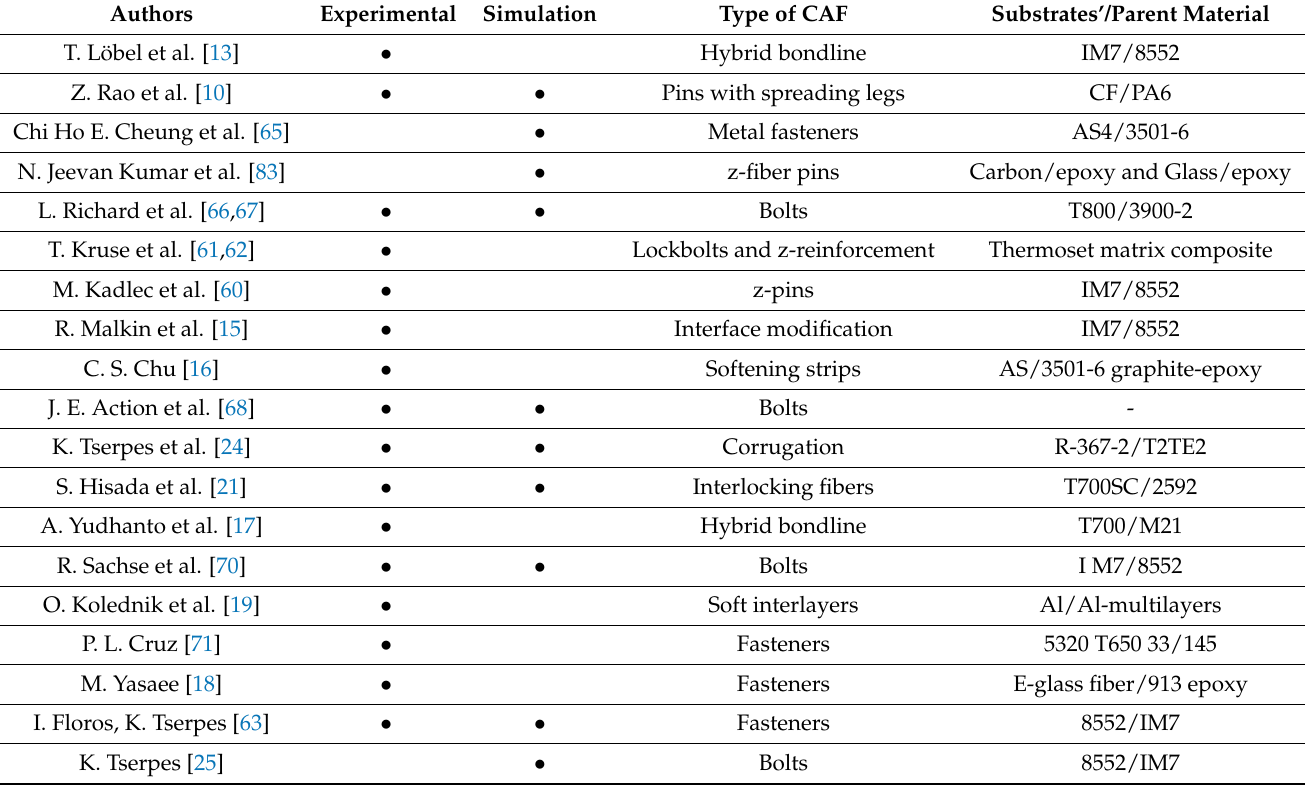
Figure 14. The embedded strip CAF concept.